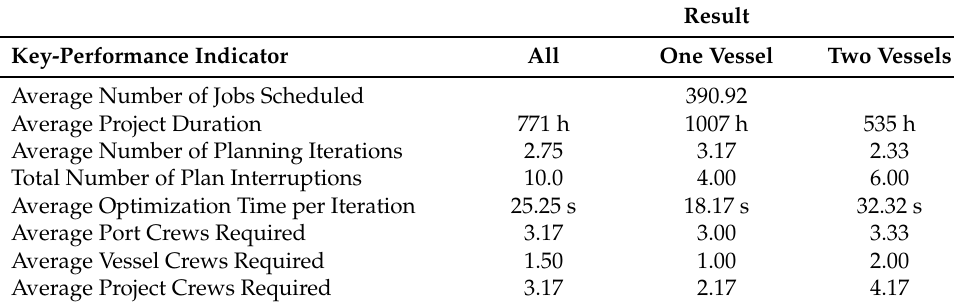
Table 6. Average results across all twelve simulation runs for the base scenario.